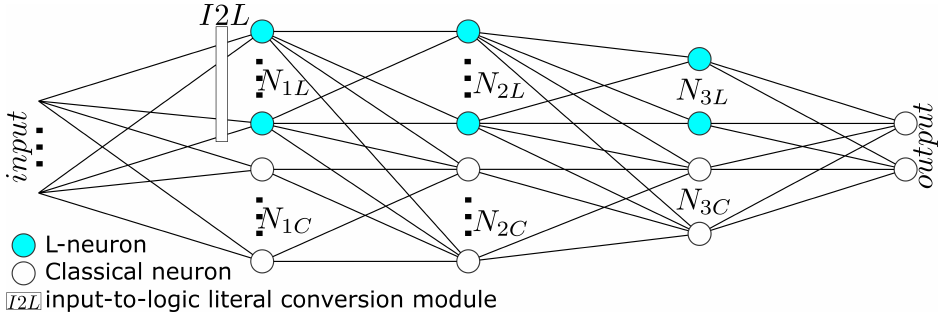
Figure 5. Architecture of the proposed hybrid